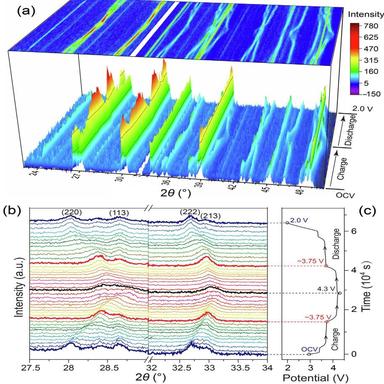
(Color online) Structural evolution of the NVPF@C electrode during Na-intercalation/extraction at 0.1 C during the 1st cycle. (a) 3D color patterns of full-scale in situ XRD, and (b) the partly enlarged in situ XRD patterns between 27.5 and 34 with (c) the corresponding GCD curve.